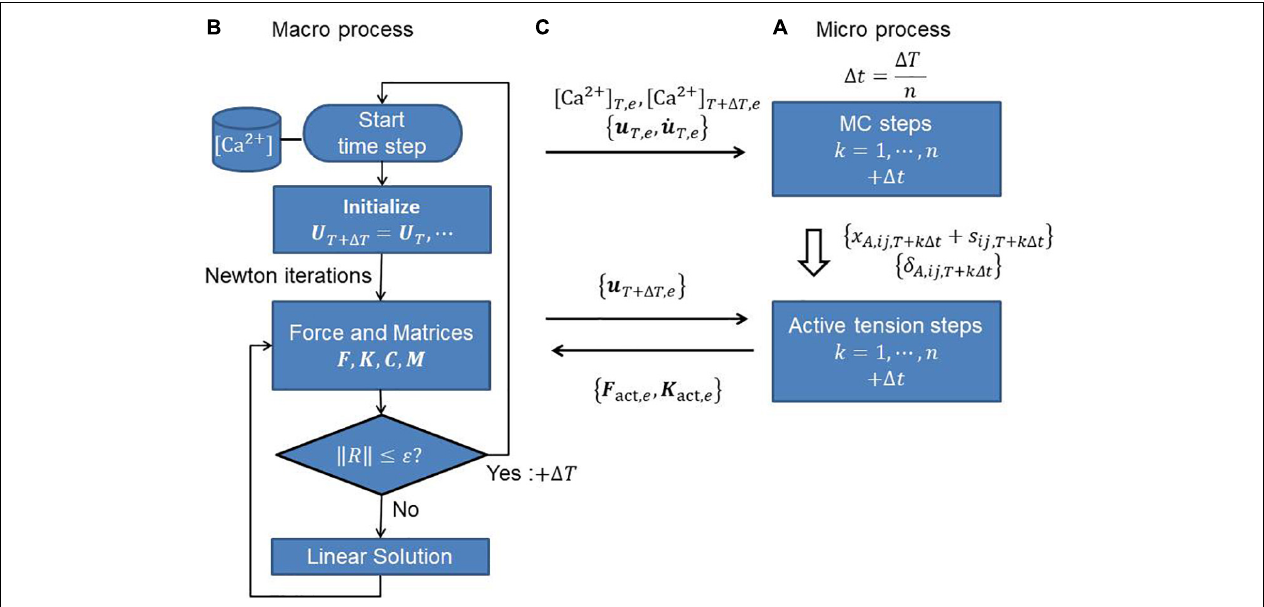
FIGURE 4 | (A) Micro and (B) macro processes, and (C) communications between them to perform the MusAsi scheme. Before the Newton iterations, the displacement u T , e and its time derivative ˙ u T , e on individual elements { e } are sent from the macro process to the micro process to perform the MC steps in the micro process. In the Newton iterations, the current displacement u T + (cid:49) T , e is sent to the micro process to compute the active force vector F act , e and the active stiffness matrix K act , e on each element e